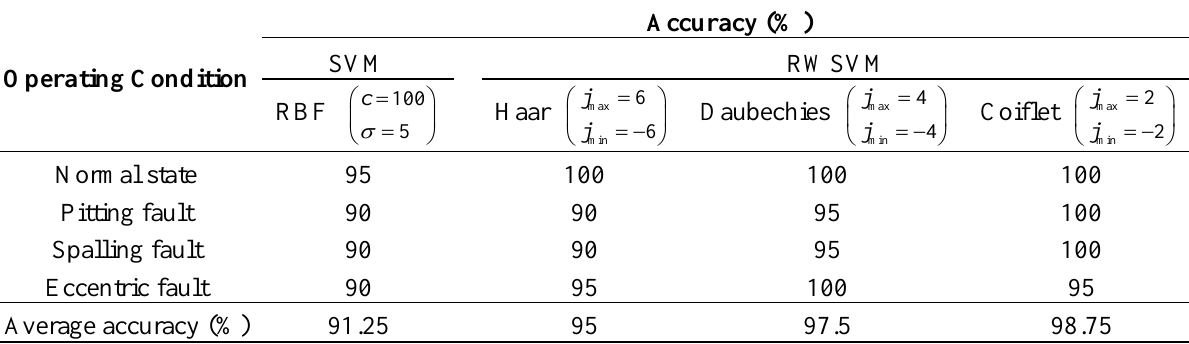
Table 3. The classified result of aero-engine rotor test